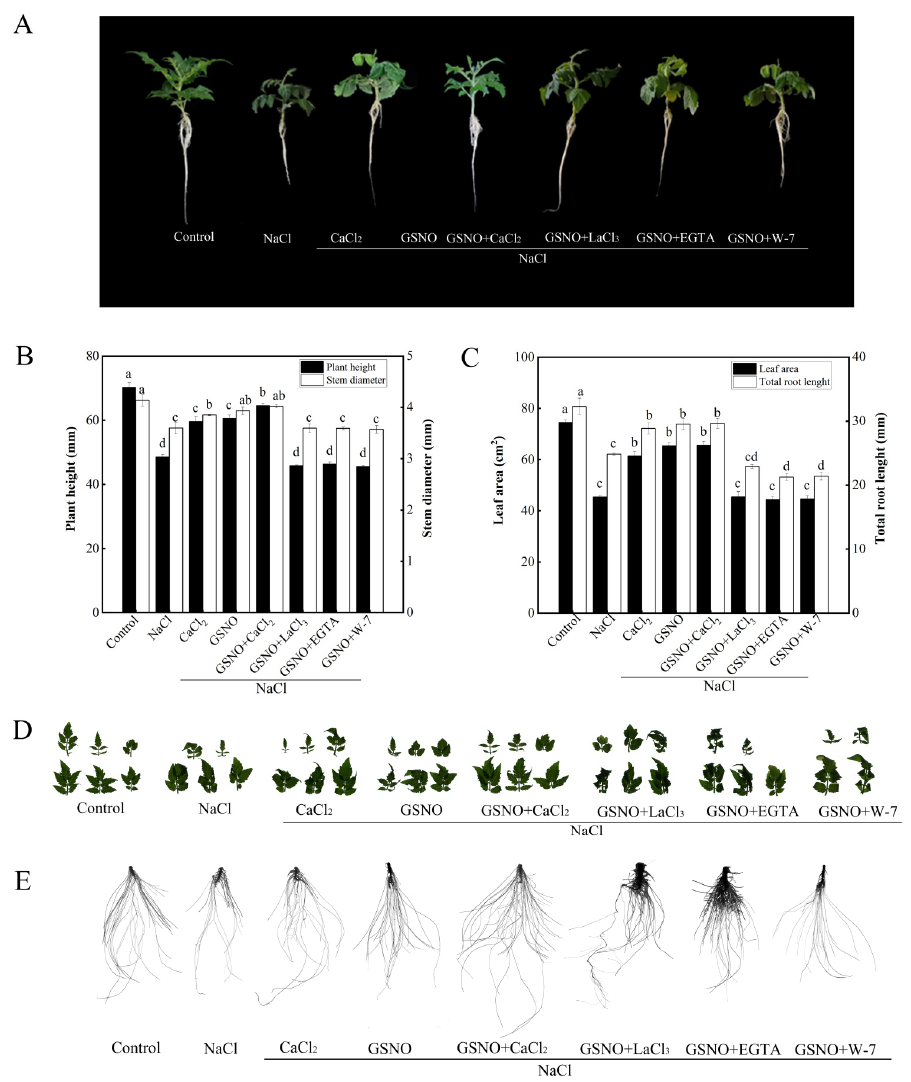
Figure 2. Effects of exogenous NO, Ca 2+ chelators, Ca 2+ channel inhibitor and CaM antagonists on growth of tomato seedlings under salt stress. ( A ): Plant phenotype; ( B ): plant height and stem diameter; ( C ): plant leaf area and total root length; ( D ): leaf phenotype; ( E ): root phenotype. The values (means ± SE) are the averages of three independent experiments ( n = 15). The columns labeled with different small letters indicate significant differences between treatments by Tukey’s multiple comparison test ( p <